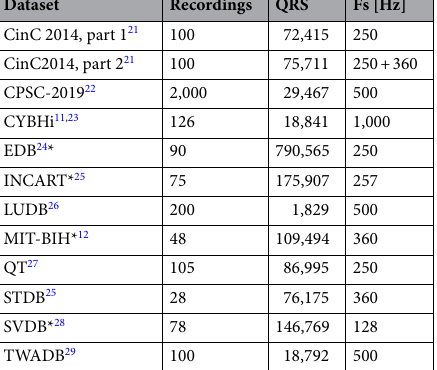
Table 2. Public data for cross-database tests. *Data were used also for QRS